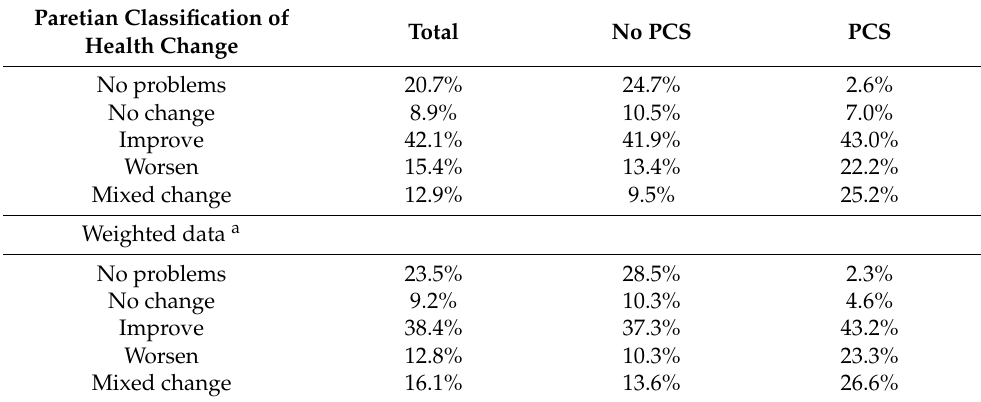
Table 4. Health profile change over time according to Paretian classification for profiles changes, for total population and patients with and without post-concussion syndrome (PCS).